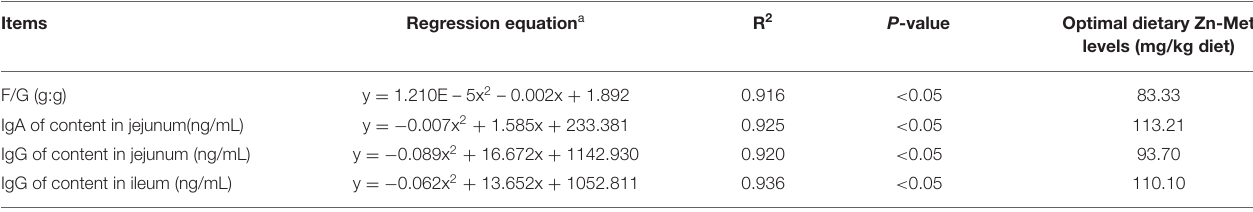
TABLE 10 | The optimal dietary Zn-Met supplementation based on different indices for ducks.